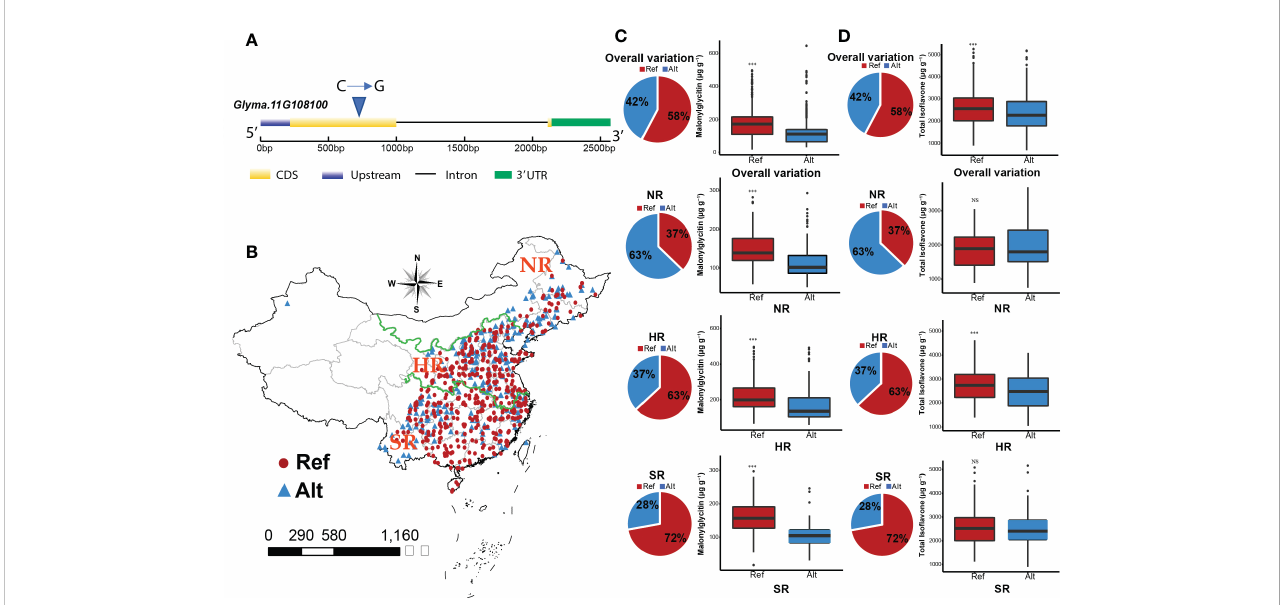
FIGURE 7 (A) Polymorphism that occurred in Glyma.11G108100 . (B) Geographical distribution of Glyma.11G108100 (NR, Northern region; HR, Huang Huai Hai valley region; SR, Southern region). (C) Natural variation of Glyma.11G108100 for malonylglycitin content. (D) Natural variation of Glyma.11G108100 for TIF